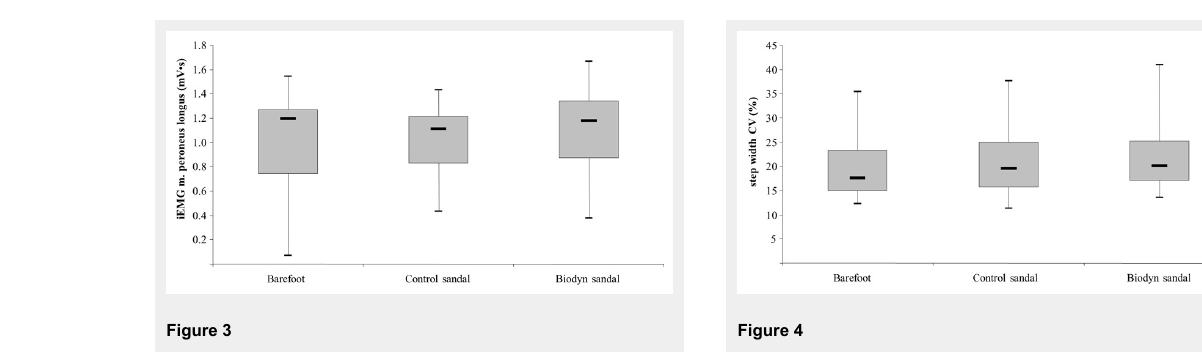
Box plots comparing muscle activity (iEMG) between testing conditions, of the m. peroneus longus obtained during bipedal stance.